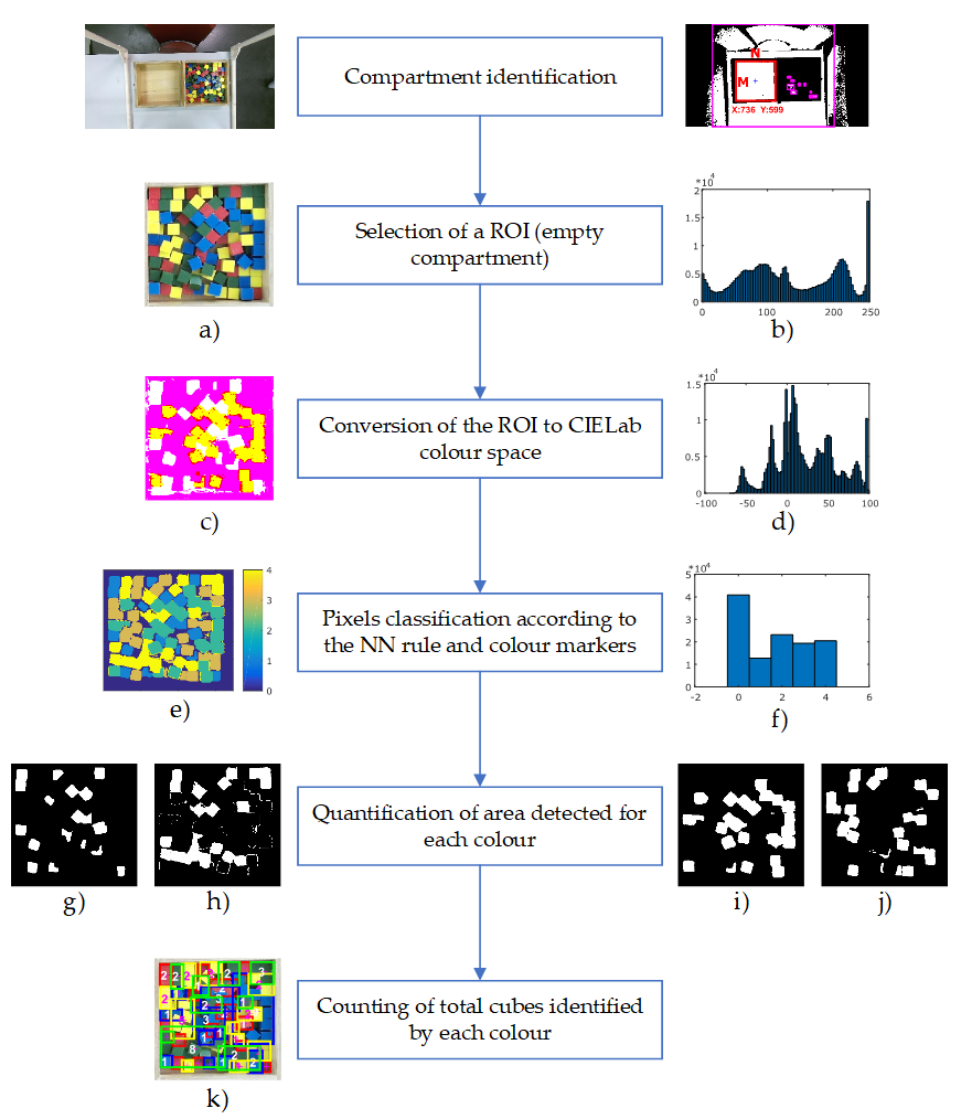
Figure 5. Procedure for automatic cube counting: ( a ) ROI extracted; ( b ) histogram of ROI in RGB colour space; ( c ) ROI in CIELab colour space; ( d ) histogram of ROI in CIELab colour space; ( e ) ROI labelled based on colour markers; ( f ) histogram of ROI labelled; ( g ) detected region for red colour; ( h ) detected region for blue colour; ( i ) detected region for yellow colour; ( j ) detected region for green colour; ( k ) total cube scoring for the ROI (Red: 17; Green: 22; Blue: 24; Yellow: